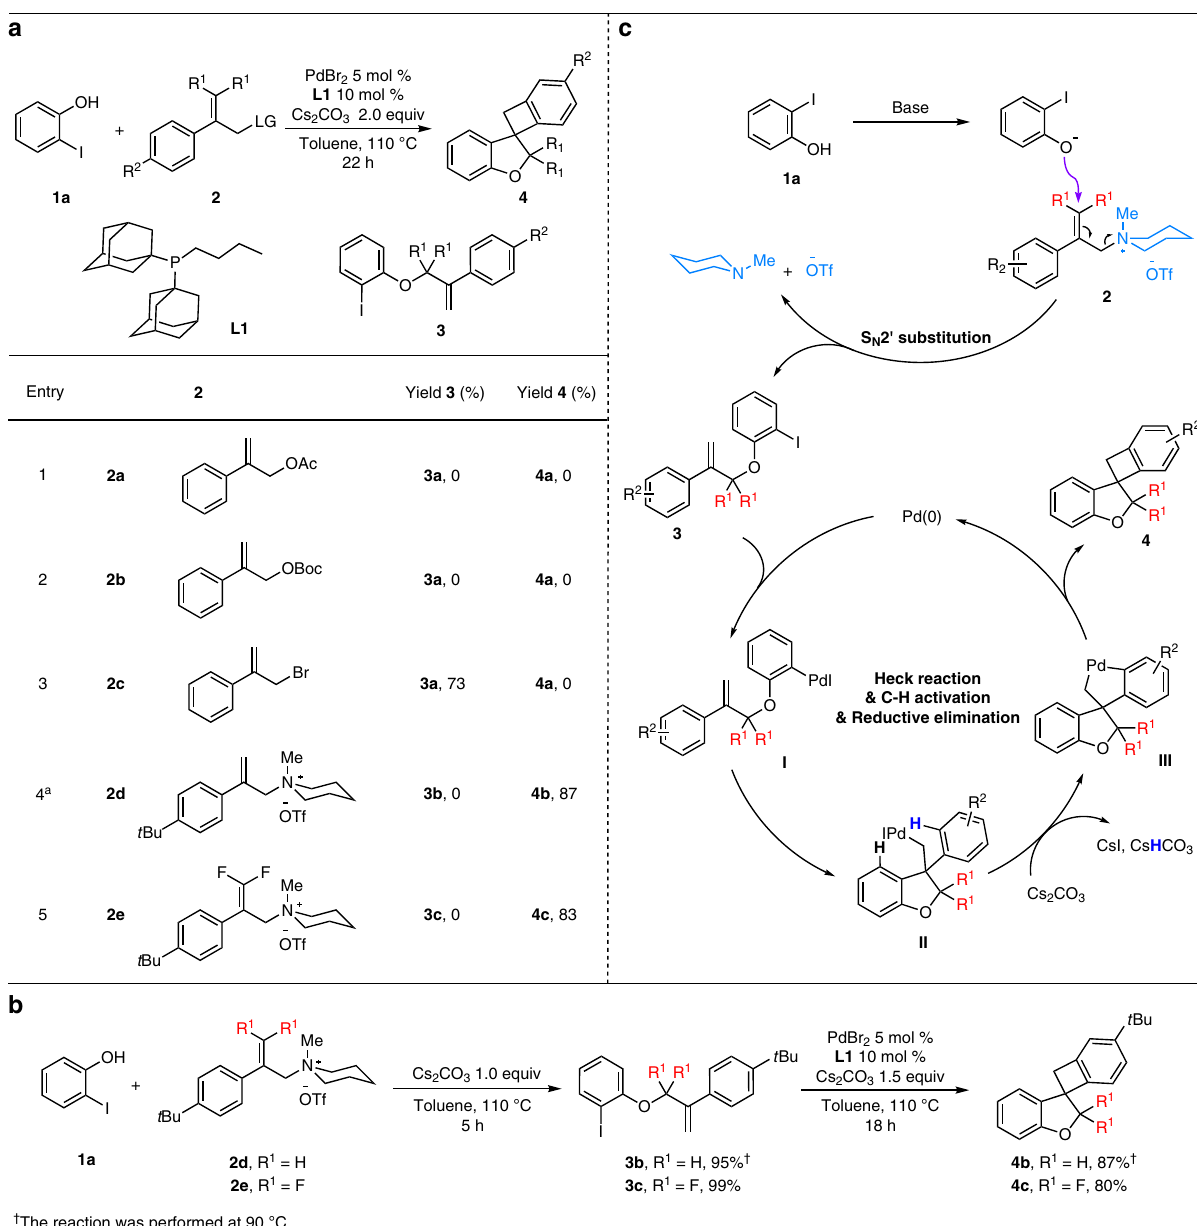
Fig. 2 Constructing molecular complexity: spiro-fused heterocycles from simple starting materials. a Preliminary results show the importance of ammonium salts as the partners of the nucleophile. b Control experiments shown that the allylic aryl ether 3 was formed in situ as important intermediate during the cascade procedure. c A S N 2 ’ substitution process was proposed for the fi rst reaction step, followed by sequence palladium-catalyzed Heck reaction/C – H activation/Pd reductive elimination to provide the target product 4